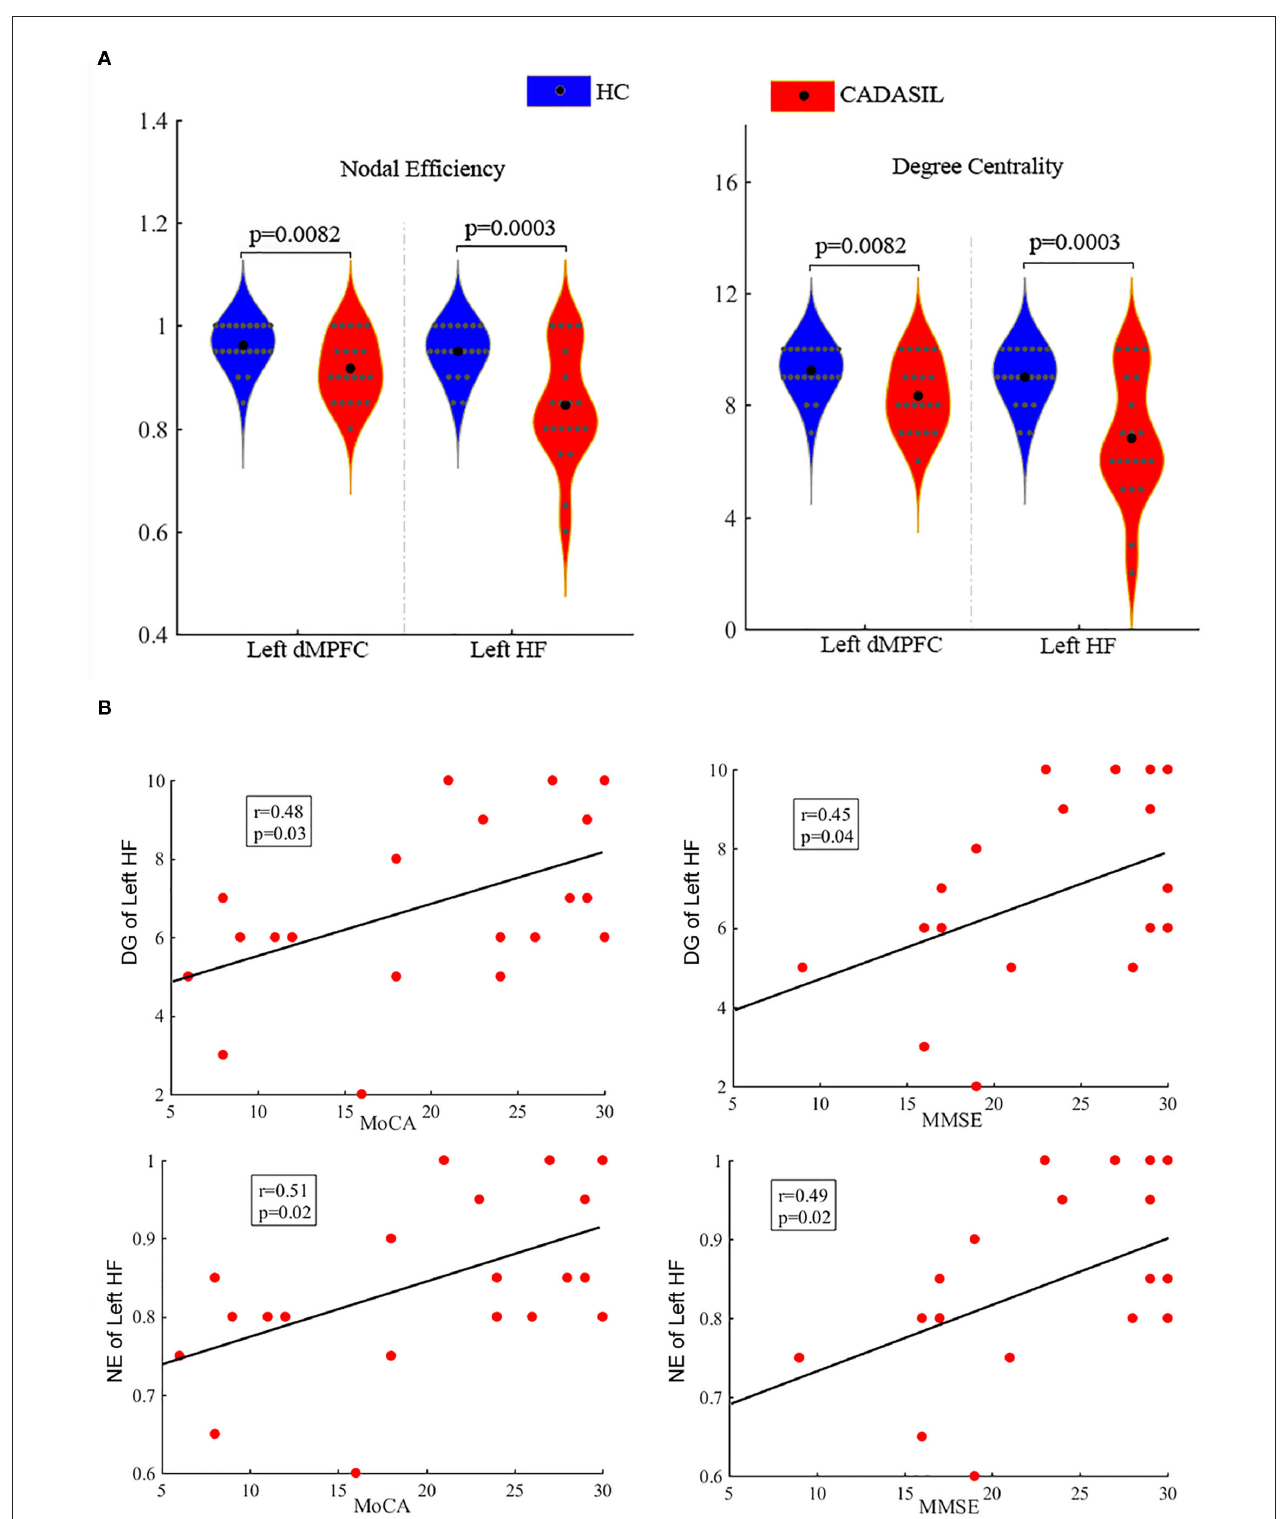
FIGURE 2 | Differences between CADASIL and control groups in topological properties and correlations between the properties and cognitive scores in the DMN. (A) Nodal efficiency and degree centrality were significantly different between the CADASIL and healthy control groups in the left DMN. The CADASIL had decreased nodal efficiency and degree centrality in the left dMPFC and HF. (B) Linear correlations between network properties in the DMN and cognitive scores in CADASIL.